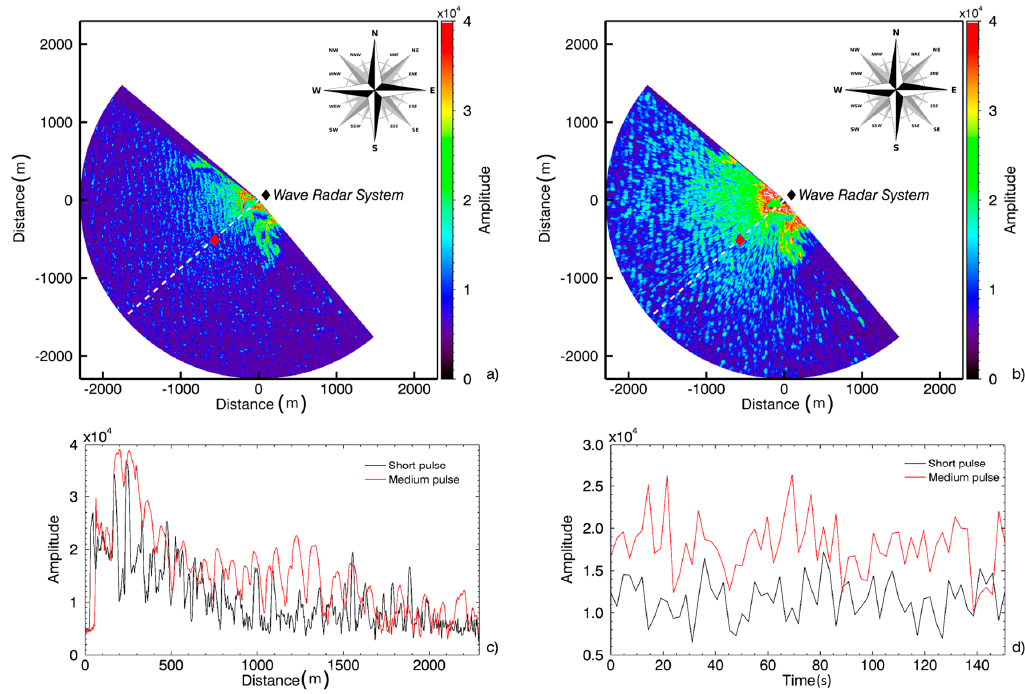
Figure 3. Radar images acquired at Cape Granitola with the short ( a ) and medium ( b ) pulse modes. ( c ) The spatial distribution of the backscattering intensity along transect marked by the dot line ( a , b ) for the short (black line) and medium (red line) pulses. ( d ) The temporal variation of the backscattering intensity at the location [x = − 672 m, y = − 590 m] marked by the red diamond ( a , b ) for the short (black line) and medium (red line) pulses.